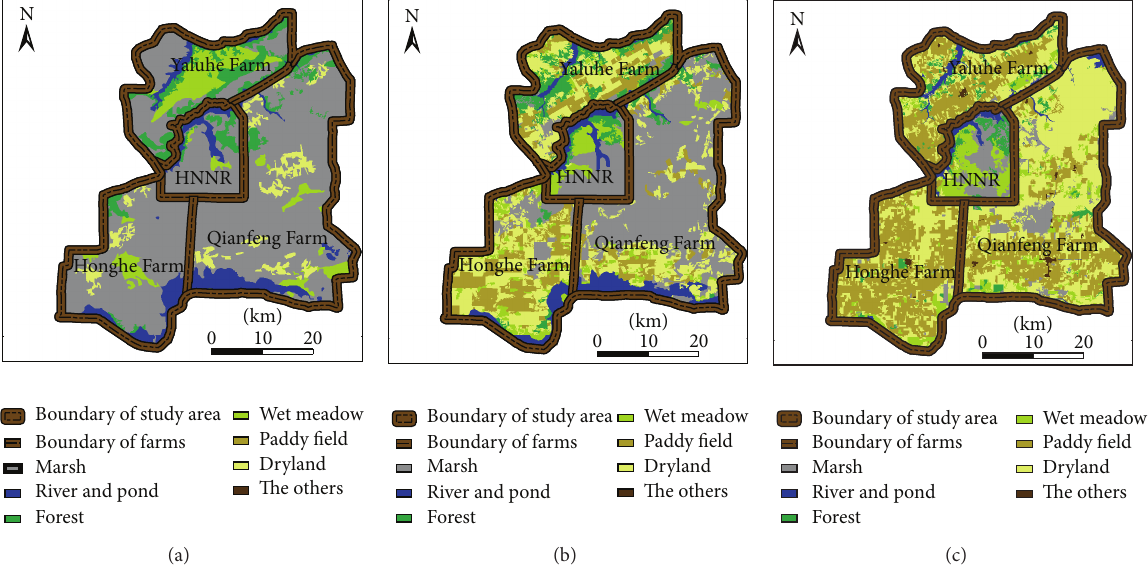
Figure 2: Changes of the wetland landscape within the past 30 years.